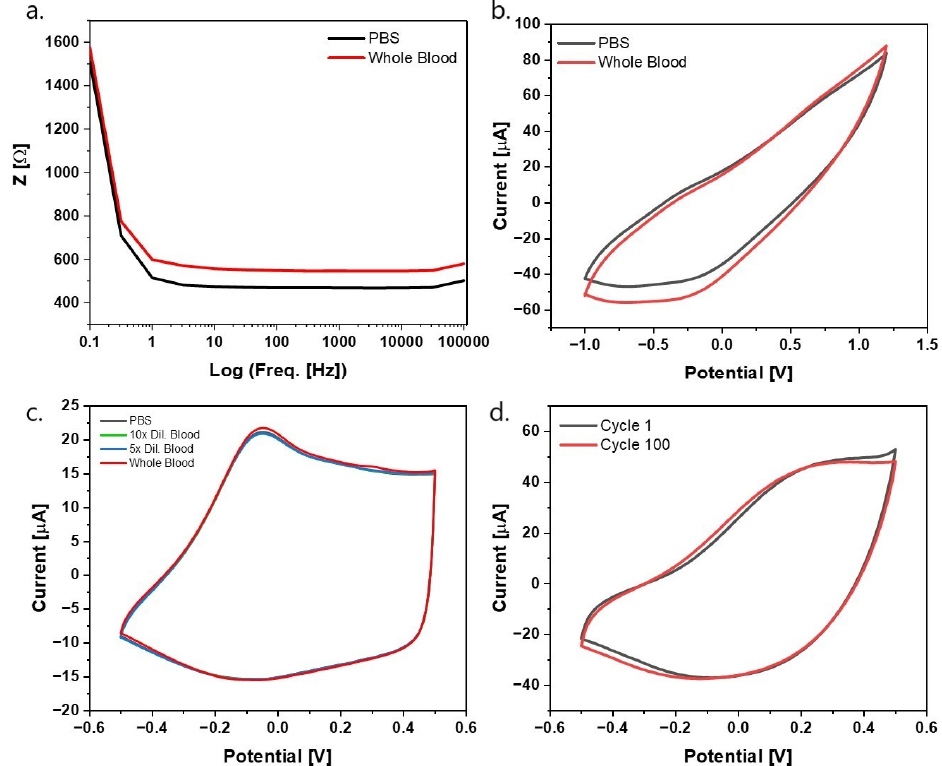
Figure 2. Electrochemical characterization of the O3ES. ( a ) Stable CV over a wide potential window; ( b ) effect of blood dilution on the electrochemical behavior of the sensor; ( c ) stability over 100 redox cycles in whole blood; and ( d ) EIS Bode plot showing impedance spectra.